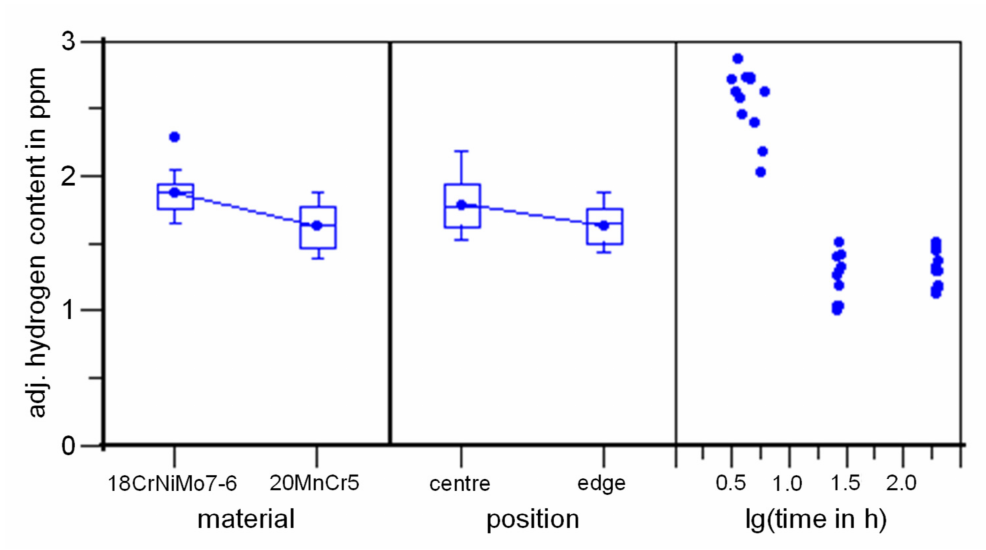
Figure 10. Effects of the factors material, position and logarithmic storage time on the total hydrogen content of the quenched samples (adj. R 2 = 0.92, F = 29).